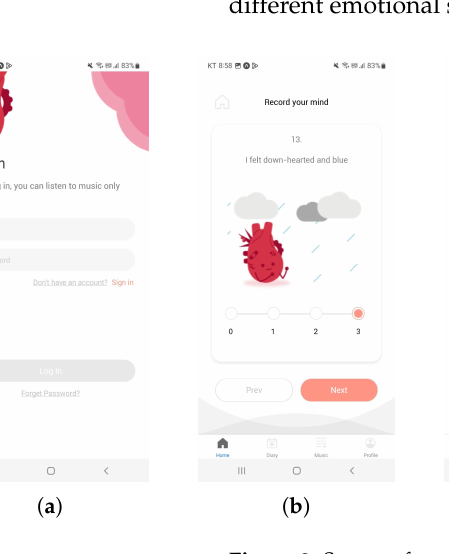
Figure 9. Screen of music recommendation process in mobile application. ( a ) Login page. ( b ) DASS-21 survey. ( c ) Score of DASS-21. ( d ) Recommended music list. ( e ) Trends of DASS score and music listening